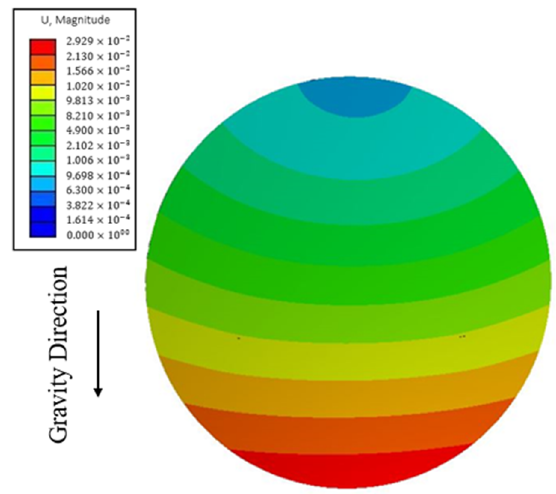
Figure 10. Mirror surface displacement cloud picture.